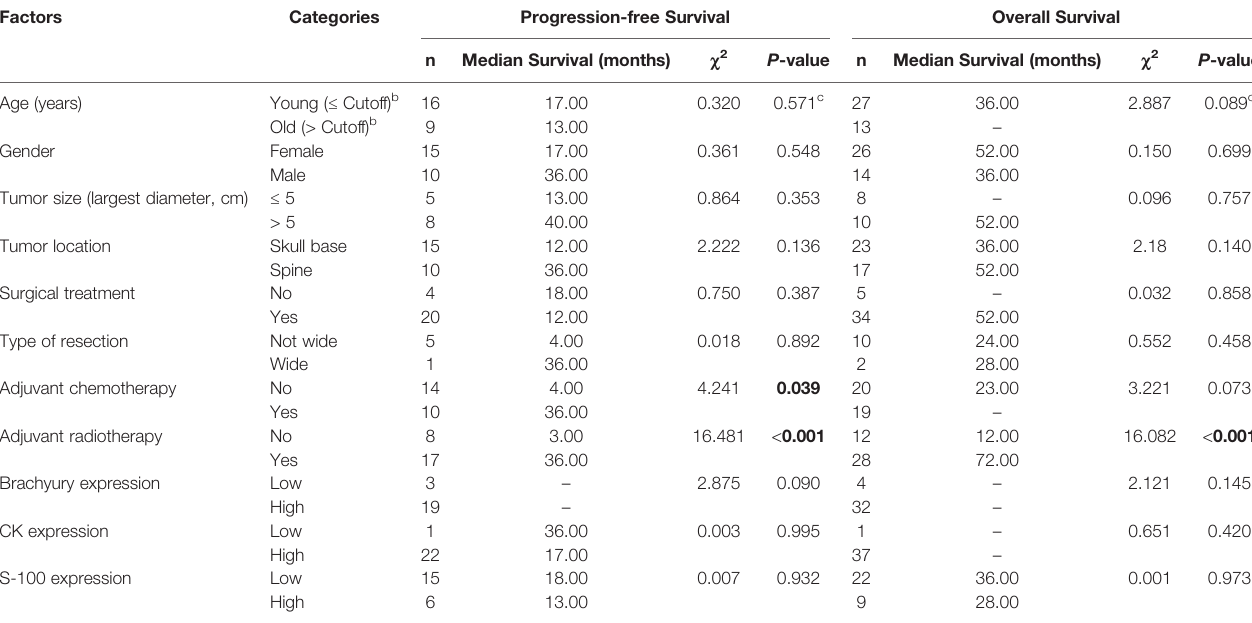
TABLE 2 | Univariate analyses of prognostic factors for progression-free survival and overall survival in patients with poorly differentiated chordoma a . Factors